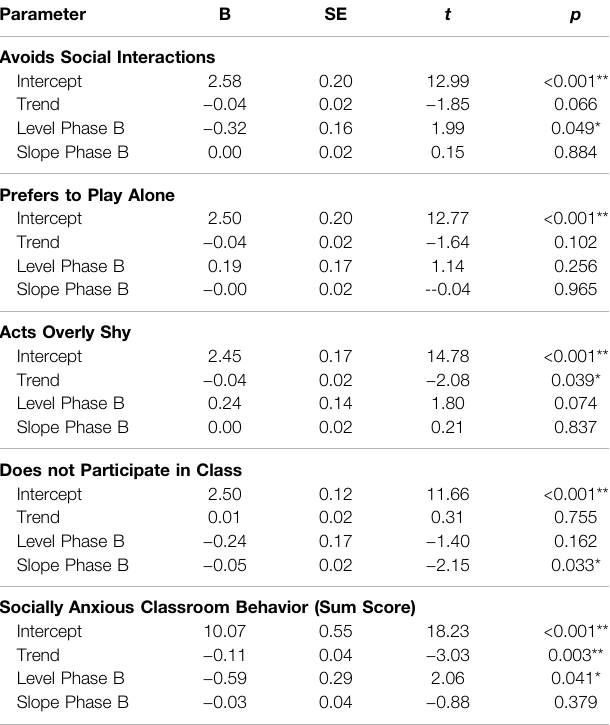
TABLE 4 | Multilevel piecewise-regression models for all behavior